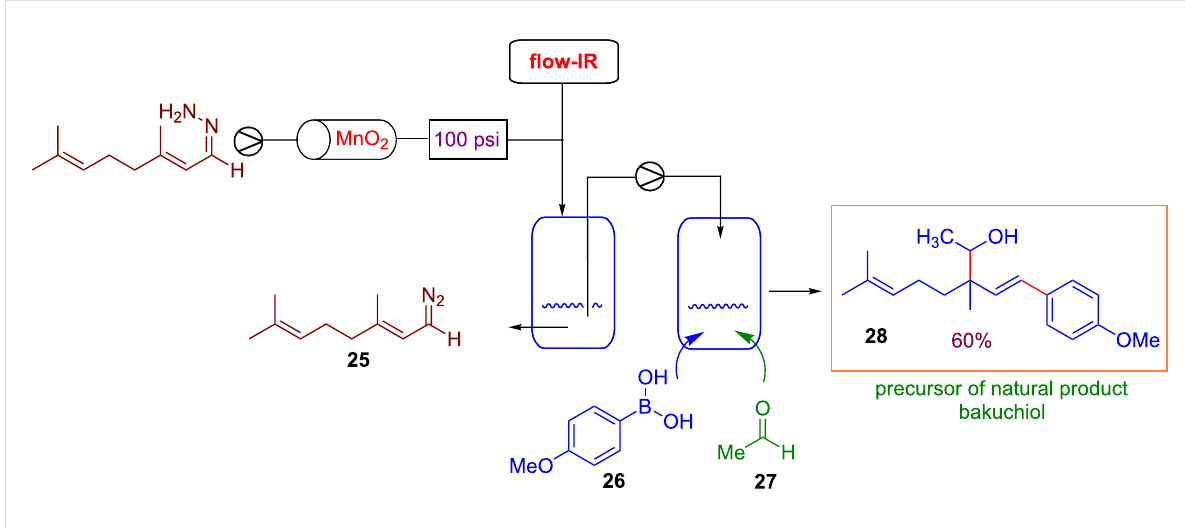
Scheme 20: Integrated synthesis of Bakuchiol precursor via flow-generated diazo compounds.